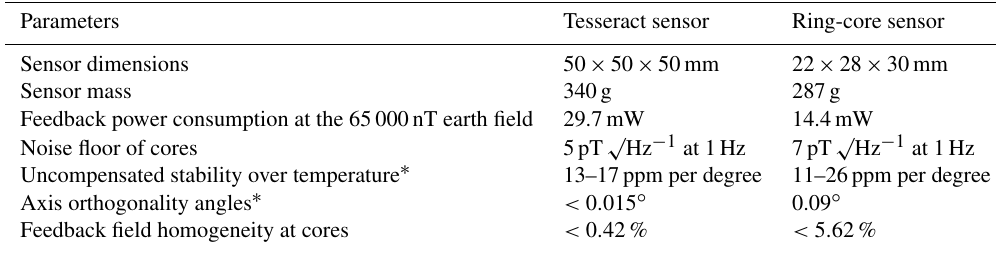
Figure 1. (a) A high-fidelity prototype of the Tesseract sensor has been constructed for testing in preparation for MAGIC: a technology demonstration of the TRACERS satellite mission’s Tesseract feedback coils is arranged in a three-axis four-loop Merritt coil which is expected to create a large homogenous null region in the sensor. Tesseract’s feedback coils are wound on a common base of 30% glass-filled Torlon. (b) A two-axis null ring-core sensor design based on Miles et al. (2013) was used in the testing described in Sect. 3 and is shown for comparison. Table 1. The Tesseract sensor’s specifications as measured in the laboratory compared with the specifications of a more traditional ring-core sensor design described in Miles et al. (2013). Tesseract is marginally larger than the Miles et al. (2013) ring-core sensor design but has much higher axis stability and magnetic feedback homogeneity, which are associated with higher instrumental stability. The uncompensated stability and orthogonality angles are both measured from − 45 to 20 ◦